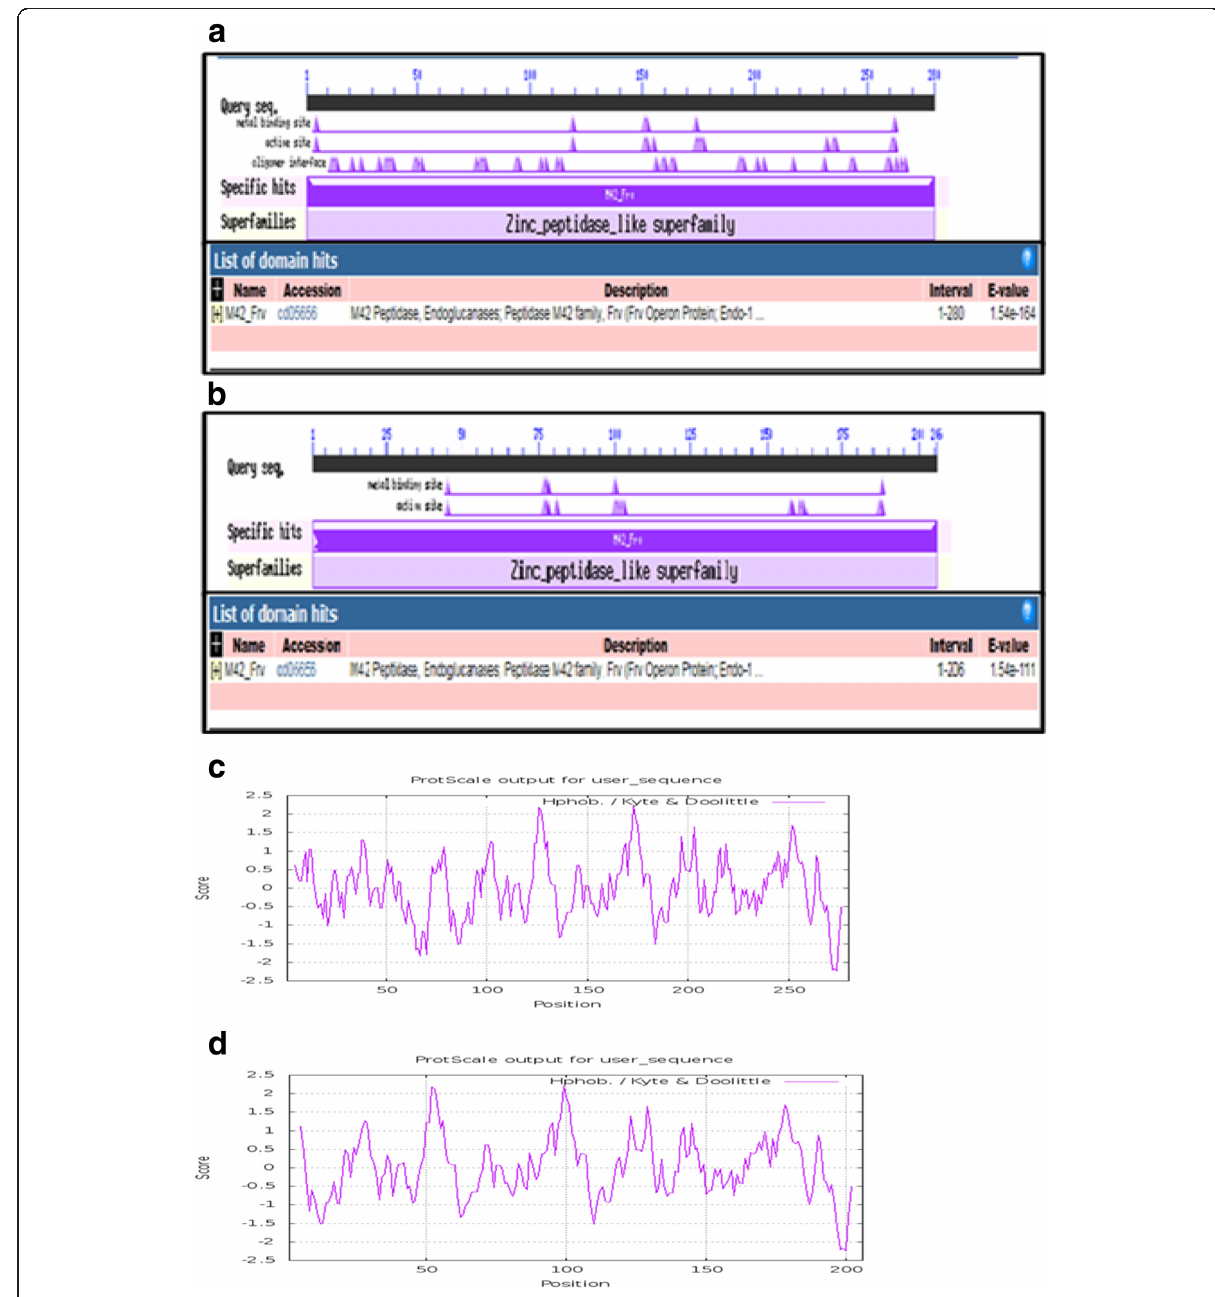
Fig. 4 Domain analysis and hydropathy analysis of PW1 and PW2 endoglucanases. Conserved domain analyses of endoglucanase of PW1 ( a ) and PW2 ( b ). Hydropathy plots for PW1 endoglucanase protein ( c ) and PW2 endoglucanase protein ( d ) were generated using